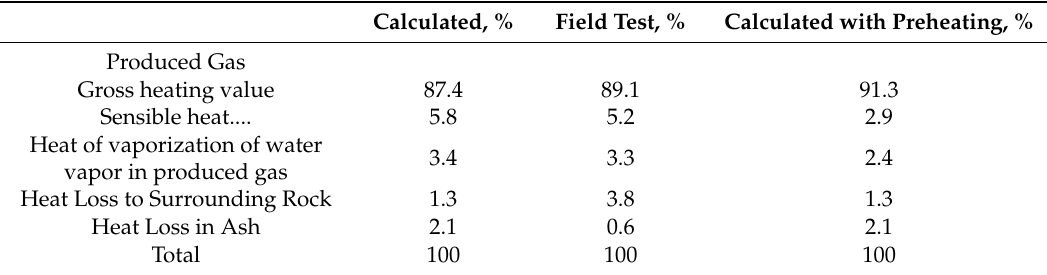
Table 13. Distribution of thermal energy from in situ coal combustion [45]. Calculated, % Field Test,